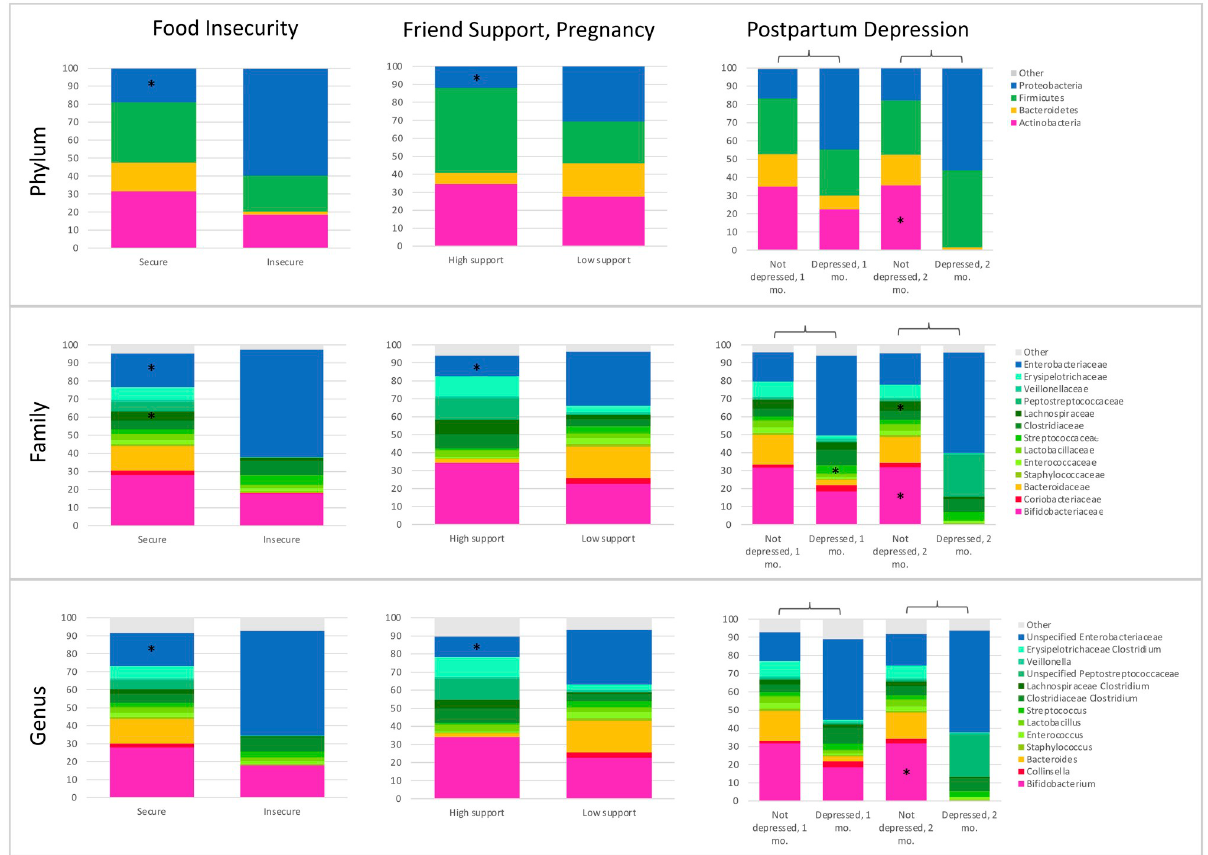
Fig 4. Food security, social support, and postpartum depression contribute to differential relative abundance of the phylum, family, and genus taxonomic levels in infant stool. � Indicates p � 0.05.